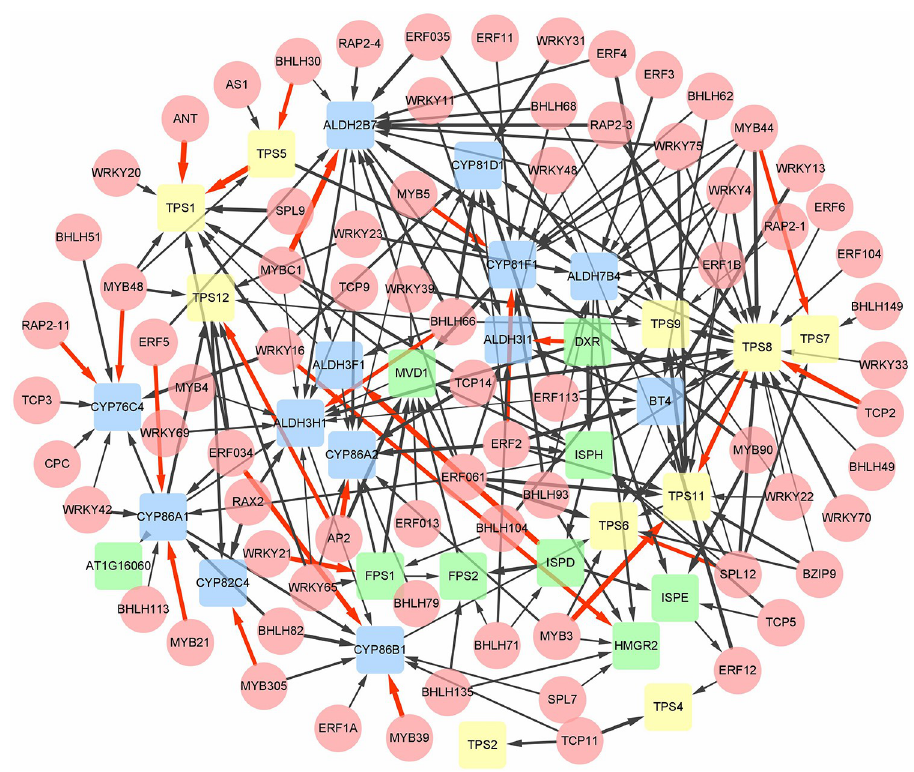
Fig 4. Genetic regulation network between transcriptional factors (TFs: Round nodes) and monoterpenoids biosynthesis genes (TPs: Round rectangle nodes). (Edges denote the association between nodes and the width of every edge denotes normalized co-expressing weight. Red edges represent high association between screened TFs and TPs. green round rectangles represent terpenoid backbone biosynthesis genes, yellow round rectangles represent monoterpenoids synthase genes and blue round rectangles represent the genes associated with post-modification stage of monoterpenoids